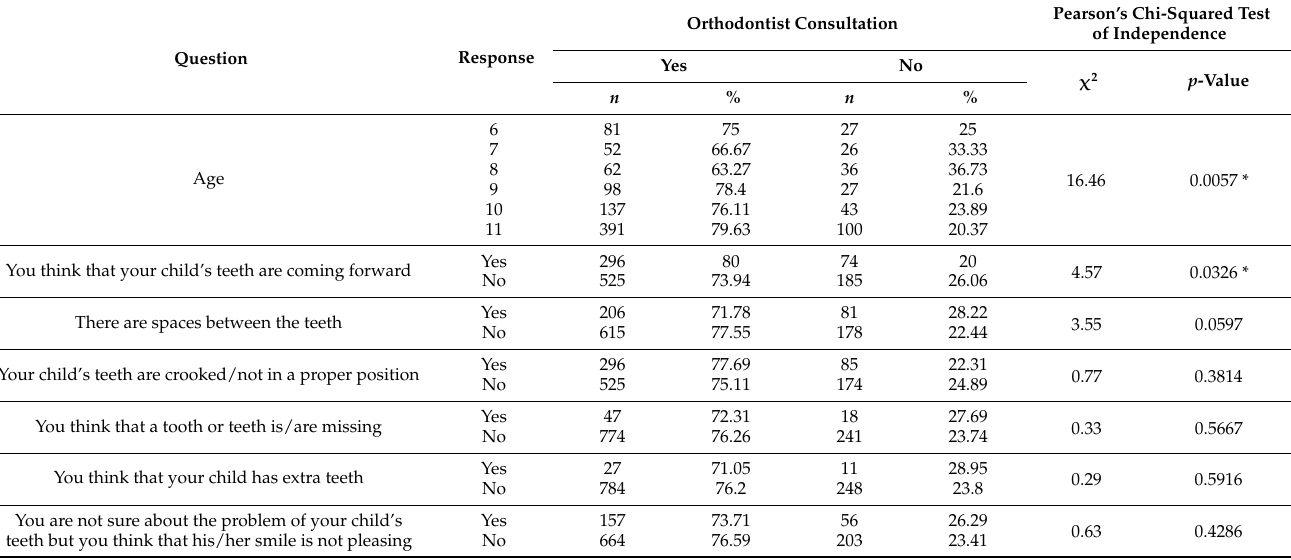
Table 4. Assessing the association between age and perceived dental problems with orthodontist consultation in children ( N =